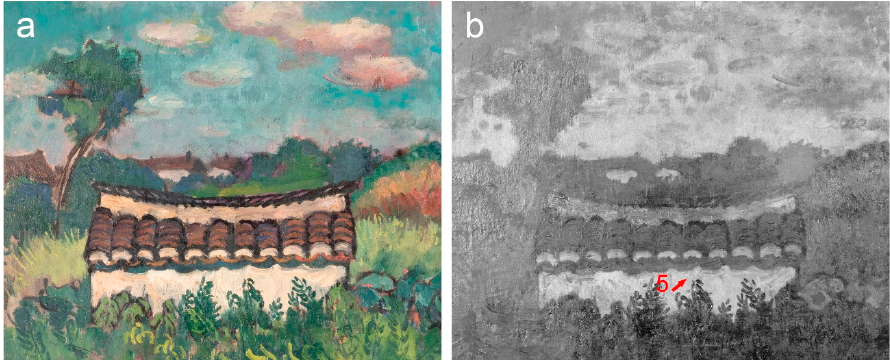
Figure 14. VIS ( a ) and corresponding UVR detail image ( b ) of Countryside in China , 1933, indicating a strong UV reflectance of white paint from the building (red arrow), suggesting a presence of lead white and/or